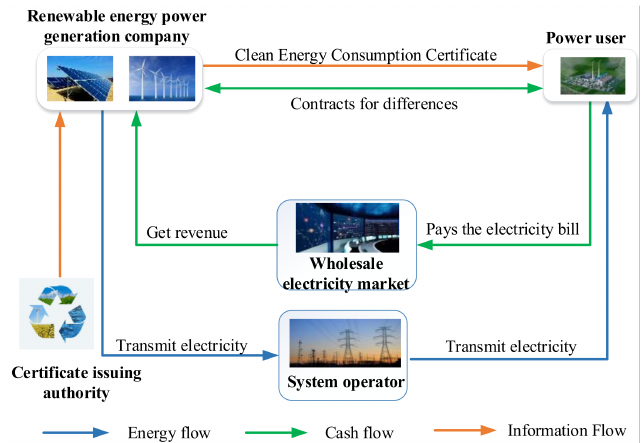
Figure 1. Financial PPA for Renewable